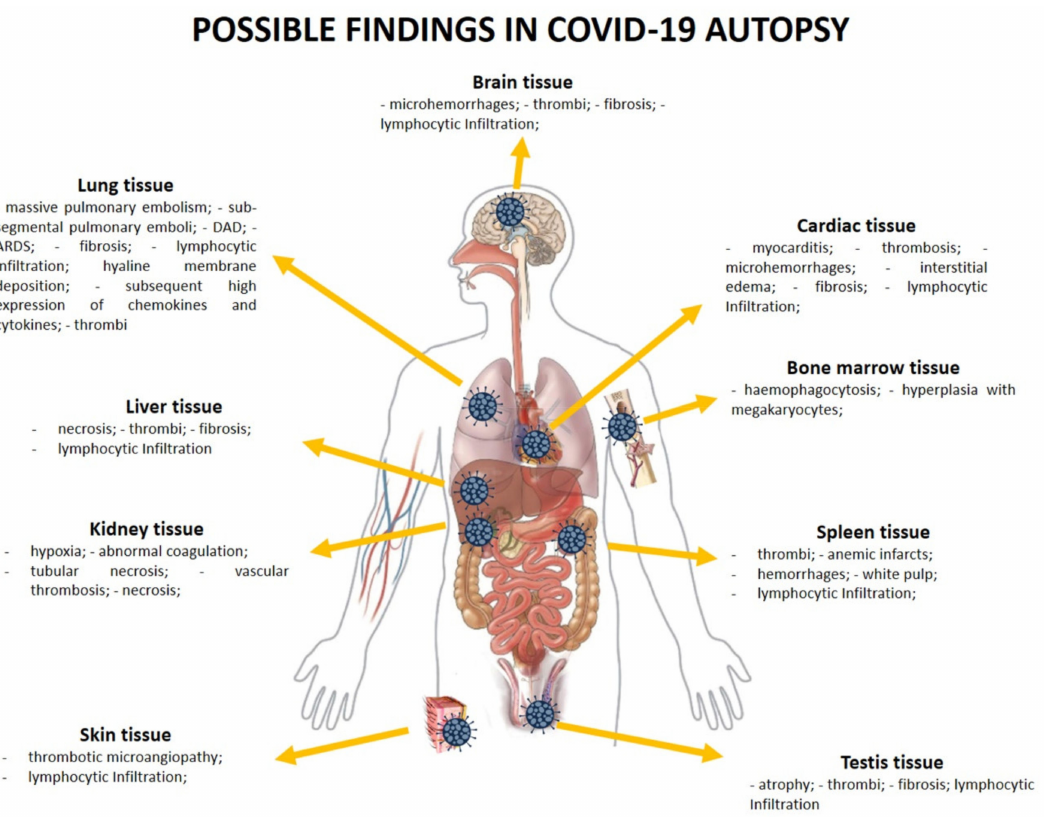
Figure 2. The possible findings in a COVID-19 autopsy (abbreviations: acute respiratory distress syndrome, ARDS; diffuse alveolar damages,